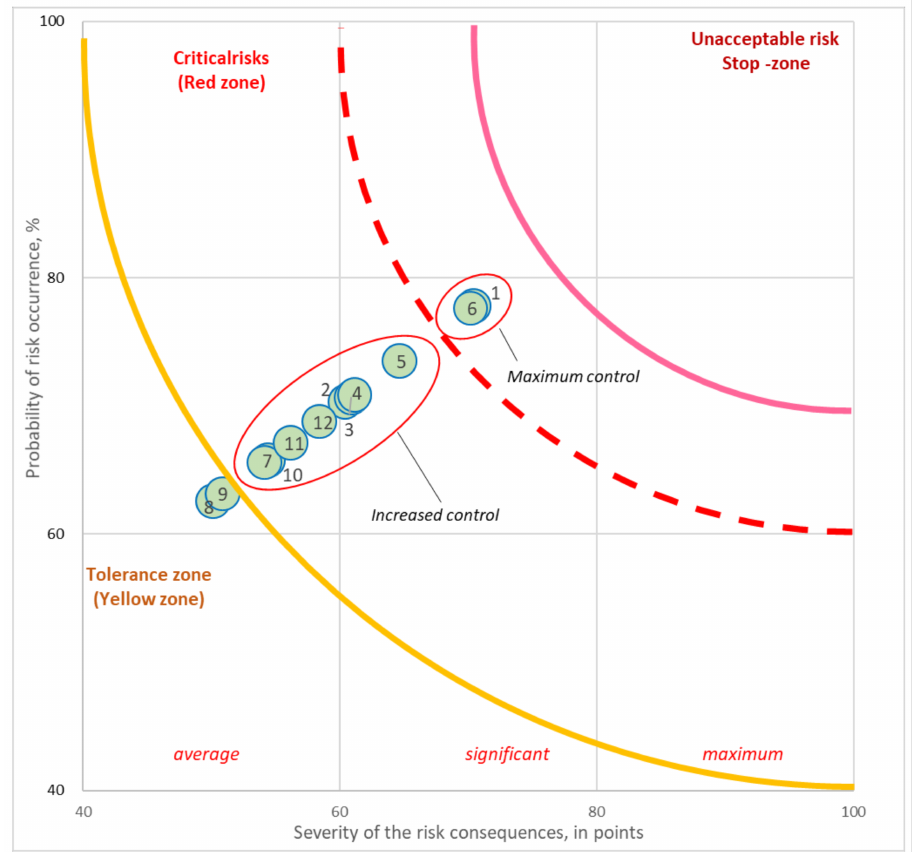
Figure 7. Risk mapping of the energy sector in Kazakhstan. Source: compiled by the authors based on the results of the